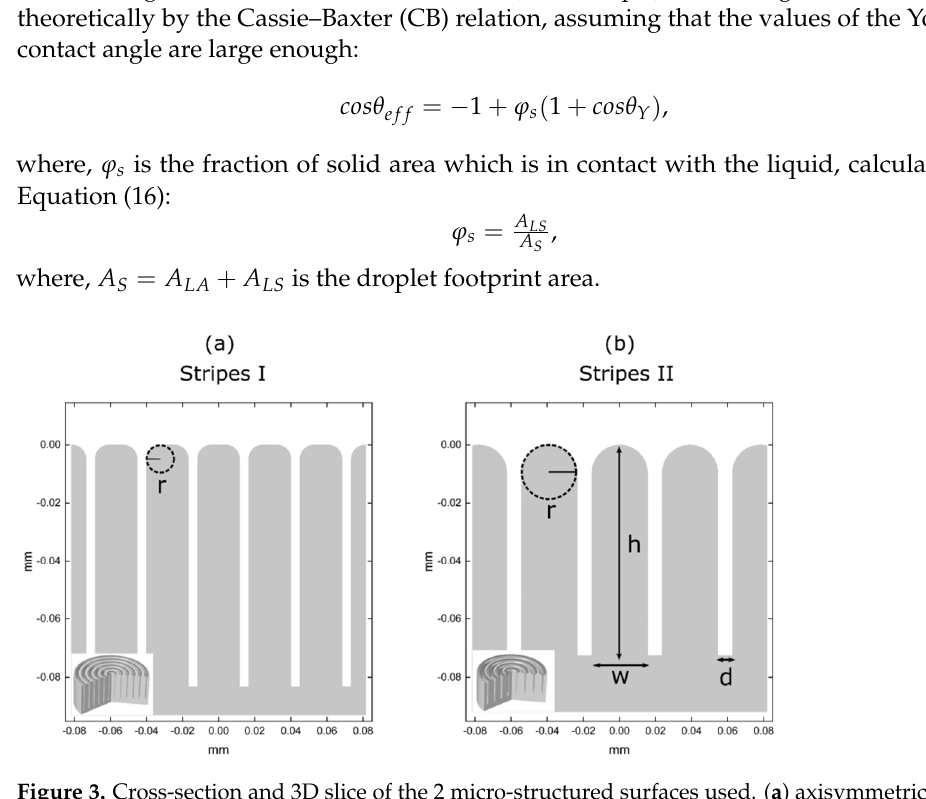
with h = 85 µ m, w = 15 µ m, d = 3 µ m and r = 5 µ m and ( b ) axisymmetric stripes with h = 75 µ m, Figure 3. Cross-section and 3D slice of the 2 micro-structured surfaces used. ( a ) axisymmetric stripes with ℎ = 85 μm , (cid:1875) = 15 μm , (cid:1856) = 3 μm and (cid:1870) = 5 μm and ( b ) axisymmetric stripes with w = 20 µ m, d = 5 µ m and r = 10 µ ℎ = 75 μm , (cid:1875) = 20 μm , (cid:1856) = 5 μm and (cid:1870) = 10 μm .